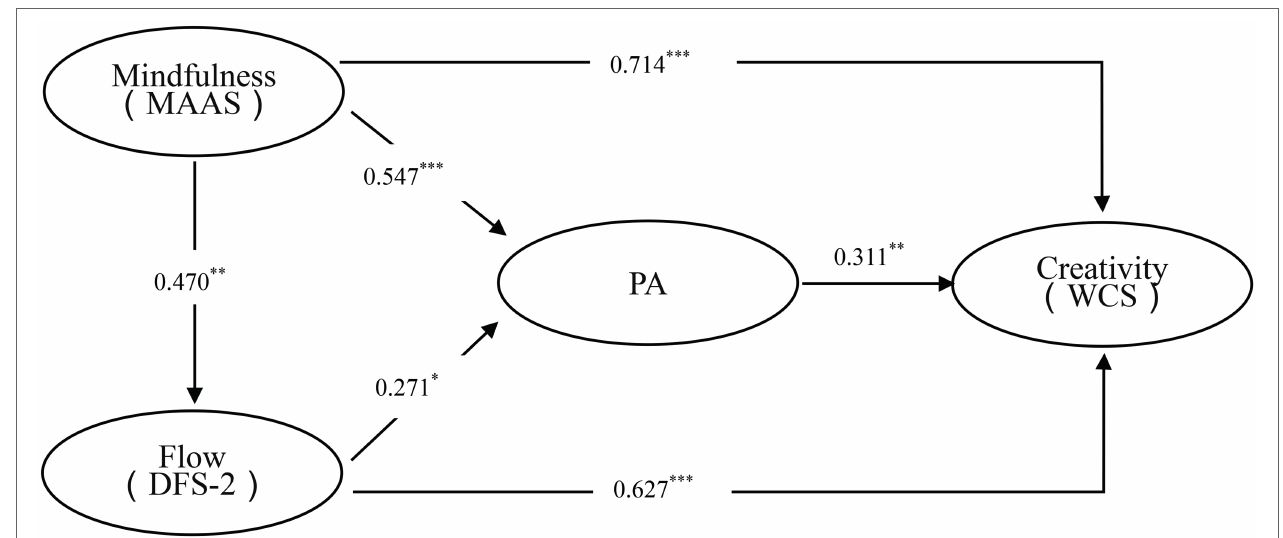
FIGURE 4 | Research framework. * p < 0.05, ** p < 0.01, and *** p <